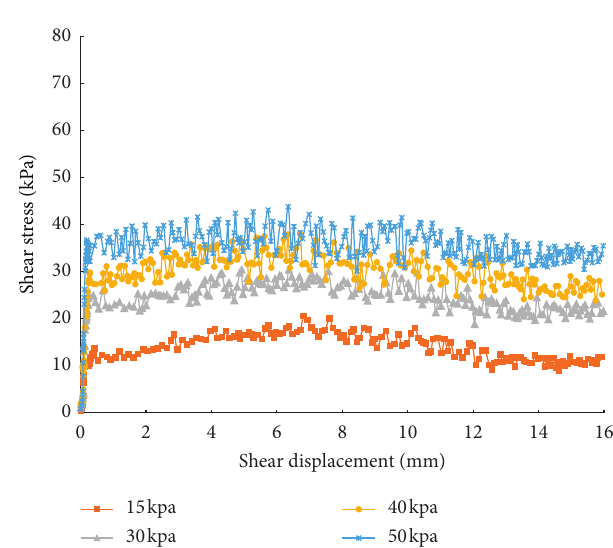
Figure 12: Shear stress-shear displacement curve of 0.4cm vertical kraft paper-reinforced